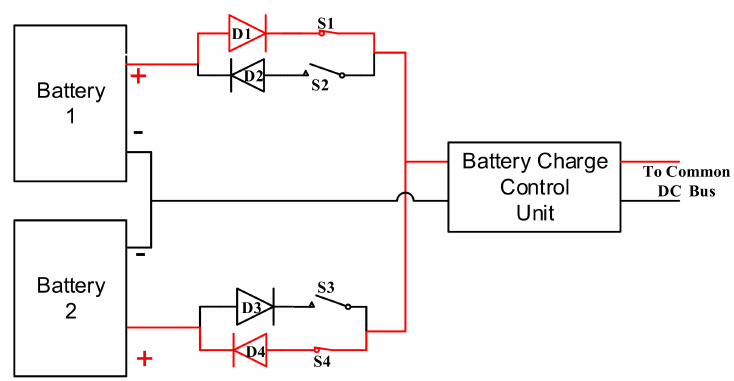
Figure 5. Circuit diagram of the dual battery mode 1